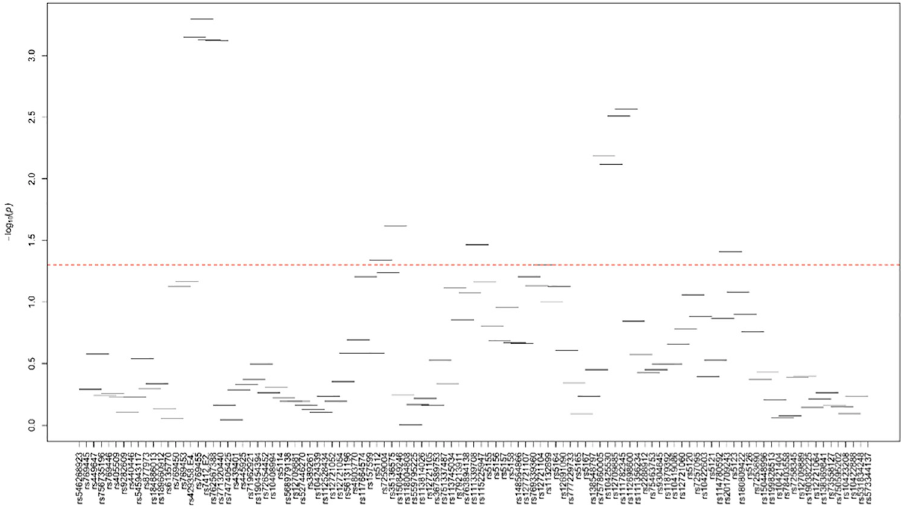
Fig 14. Plots of haplotype-based association analysis results for ApoA1 in African blacks. Horizontal lines represent the 4-SNP windows. X-axis shows the SNPs genotyped in the regions based on the order of APOE , APOC1 , HCR1 , HCR2 , APOC4 and APOC2 while the Y-axis shows the–log (global p-value) with red line representing the p- value threshold (P =